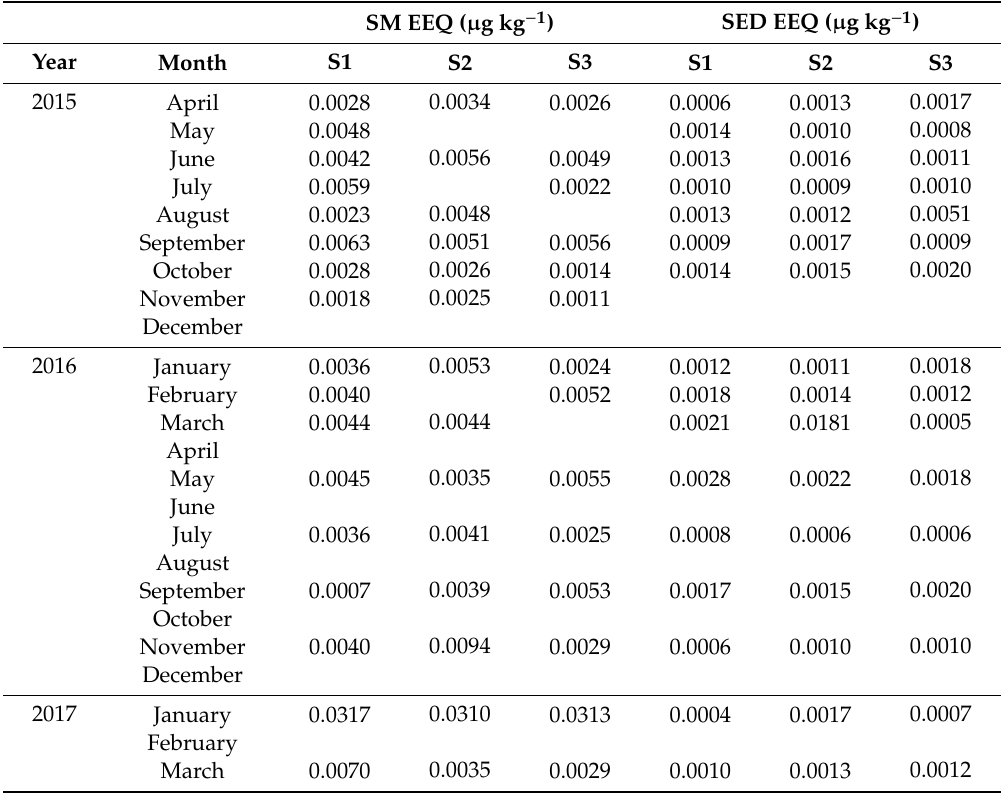
Table 1. Calculated estradiol equivalent concentrations (EEQs) for suspended matter (SM) and sediment samples (SED) collected during two years (April 2015 to March 2017, samples taken in triplicates) at stations S1 to S3 in the Kaštela Bay (Adriatic Sea